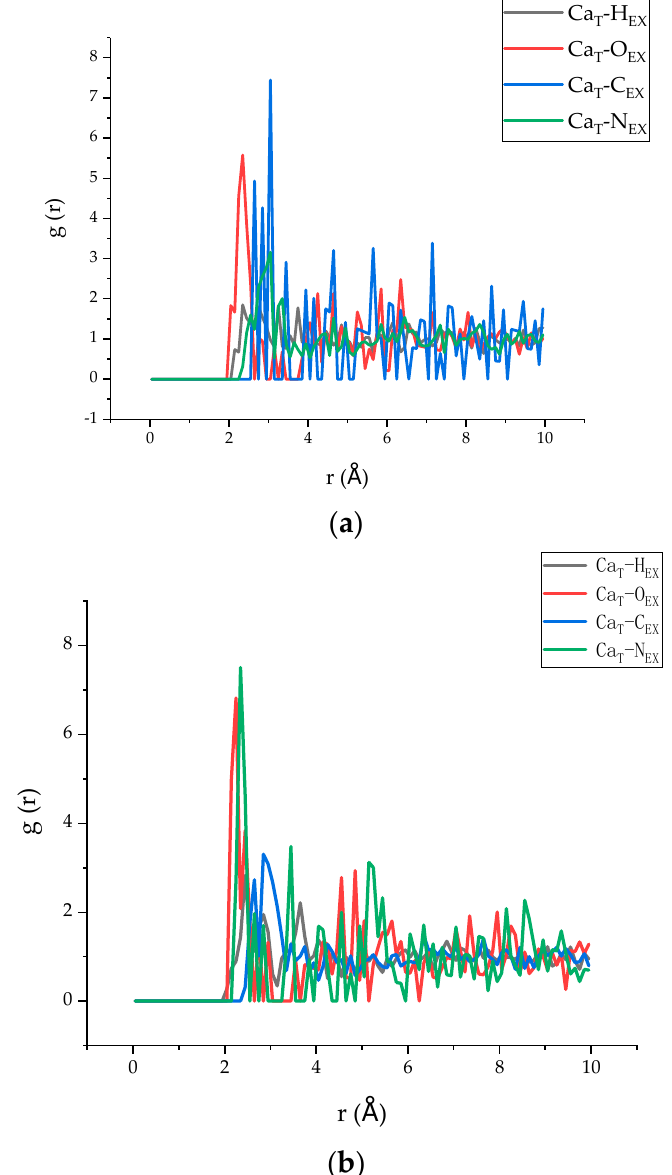
Figure 12. The RDF of models 5 and 6. ( a ) The RDF of model 5. ( b ) The RDF of model 6. In addition, because the O and H atoms between the interface may form hydrogen bonds and increase the interfacial binding energy [50], the RDF of H in the tobermorite and O in the epoxy resin in model 5 and model 6 was simulated, and the results are shown in Figure 13. Obviously, the first peak of both models appeared at around 1.75 Å, indicating that the hydrogen bond existed, since, according to the literature, an RDF value between O and H atoms of less than 2.45 Å may indicate the existence of a hydrogen bond [51]. Therefore, based on the current results, it can be deducted that the interfacial binding energy not only consists of the interaction between Ca and other atoms in the epoxy resin, but also of the hydrogen bonding between O atoms and H atoms. Similarly, the